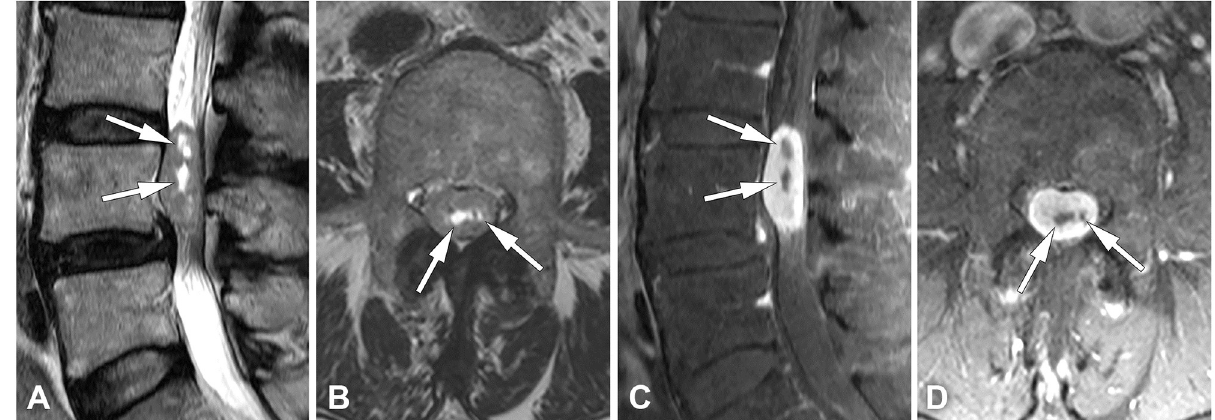
Fig 3. A schwannoma in a 59-year-old woman. ( A ) Sagittal and ( B ) axial T2-weighted images show an intradural extramedullary mass on the L4 level with measurable cyst formation (arrows). ( C ) Sagittal and ( D ) axial fat-suppressed contrast-enhanced T1-weighted images show relatively homogeneous enhancement except for non-enhancing cystic portions (arrows).